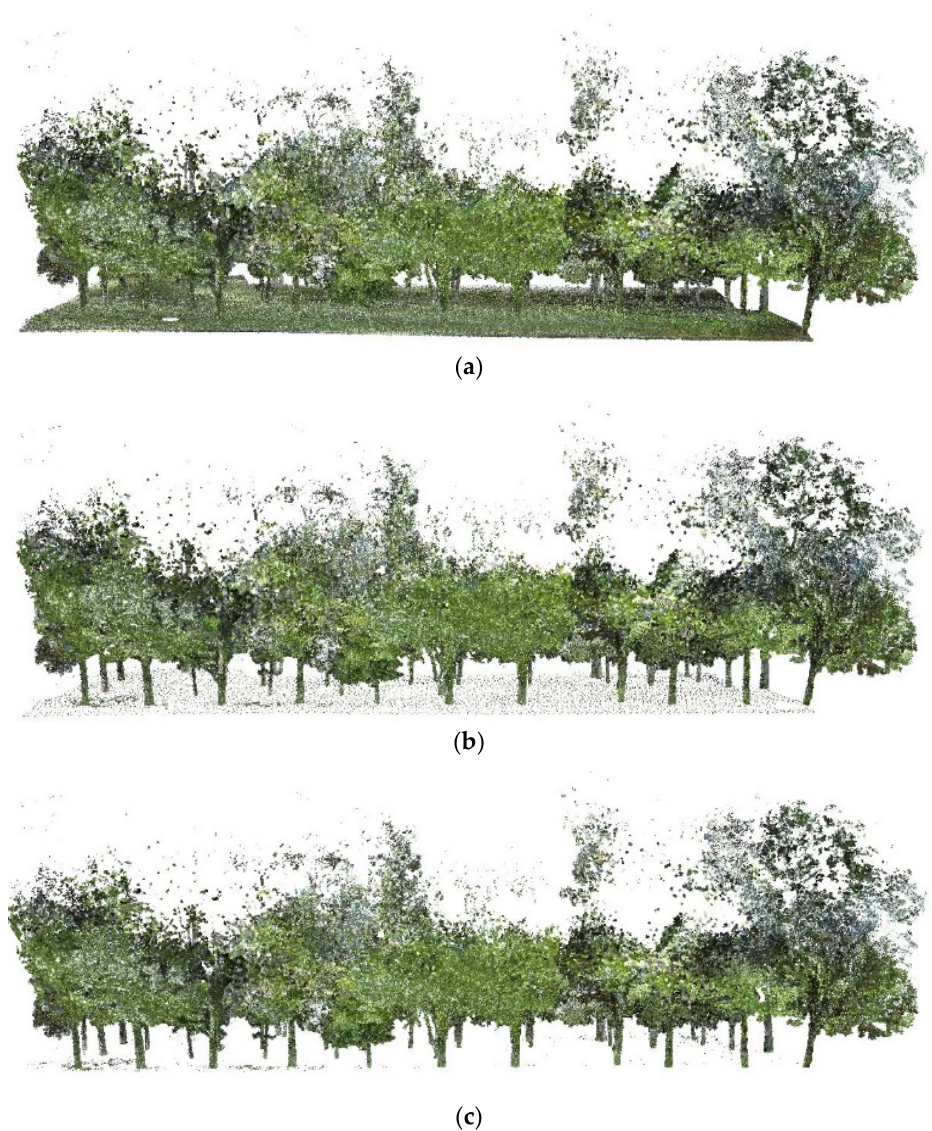
Figure 15. Classification and normalization of ground points. (( a ) shows the original point clouds; ( b ) shows the classification of ground points; ( c ) shows the filtering after classification of ground points).